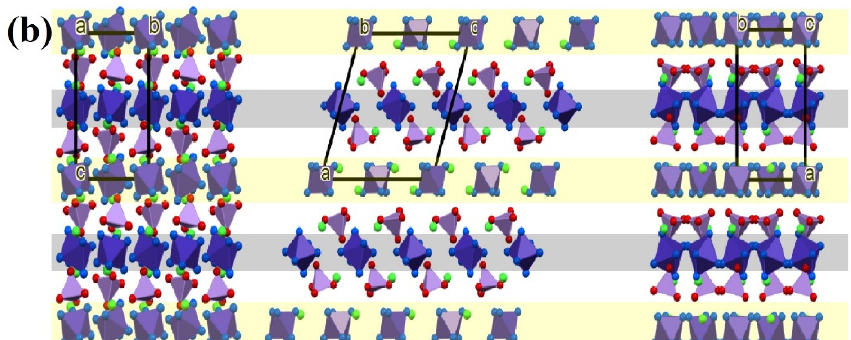
Figure 3. ( a ) Packing arrangement in the crystal of hexaamminecobalt (III) dichloro permanganate. ( b ) Packing arrangement in the crystal of compound 1 from various directions. Different cation layers are indicated by colored rectangles. Layers of cation A are indicated by yellow and layers of cation B are indicated by gray (the structure is drawn in stick representation).